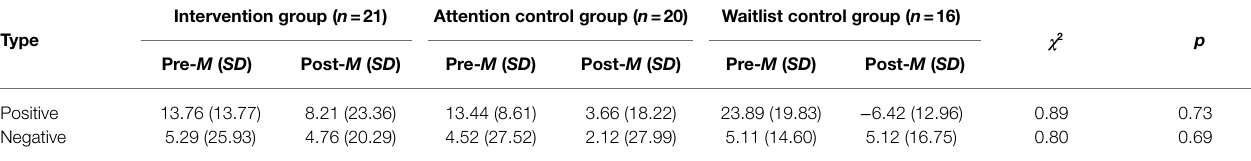
TABLE 3 | One-way repeated measures ANOVA between the groups for the PSQI and SF-36 questionnaires (all participants). TABLE 4 | Kruskal–Wallis analysis between the groups for the dot-probe task (all participants).